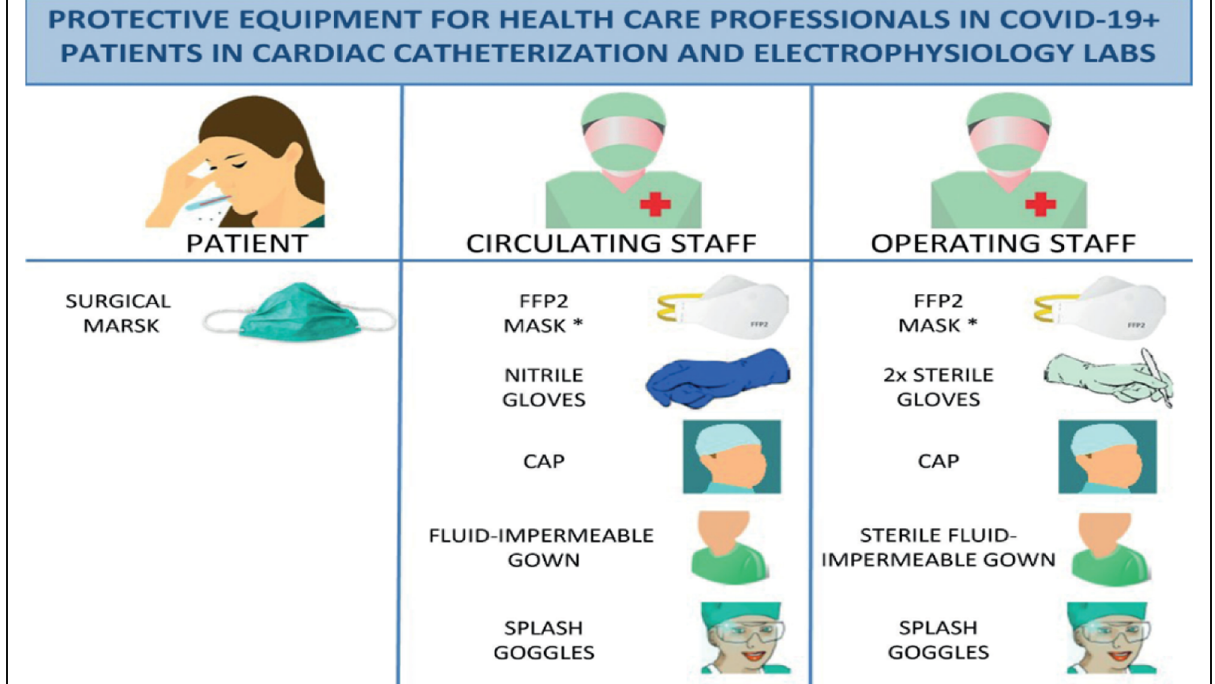
Fig. 2 Protective equipment for healthcare professionals in COVID-19+ patients in cardiac catheterization labs. Asterisk denotes for the implantation of pacemakers, ICDs, and transcatheter prostheses, place a surgical mask over the FFP2 mask. FFP2, filtering face piece type 2